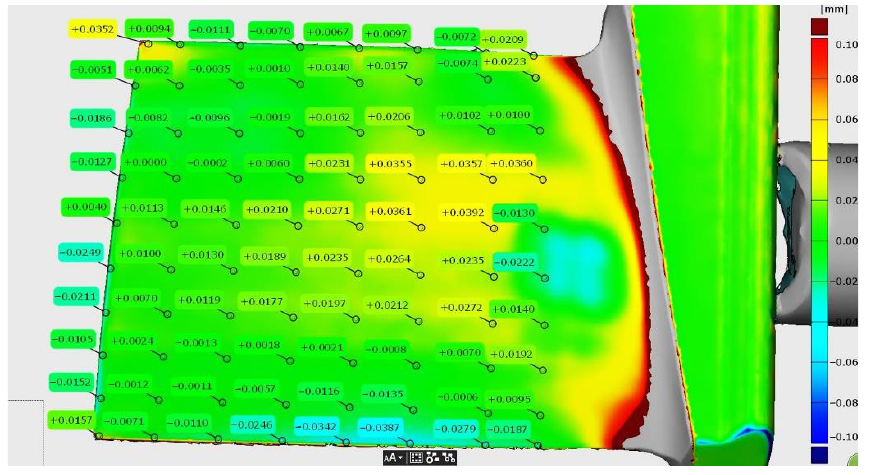
Figure 18. The measured allowances after grinding.